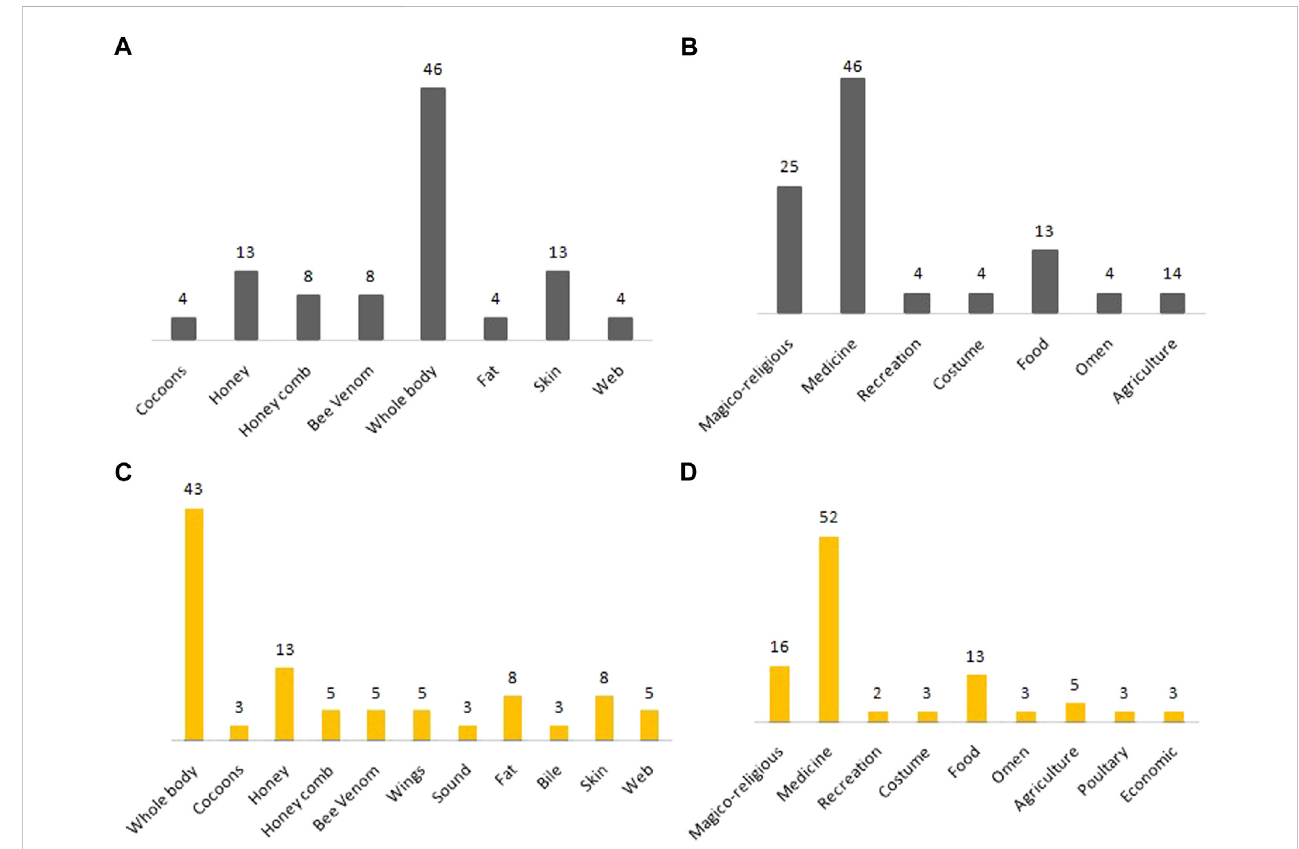
FIGURE 2 Percentage of used parts and ethnozoological practices of documented species in Jammu (A,B) and Kashmir (C,D)